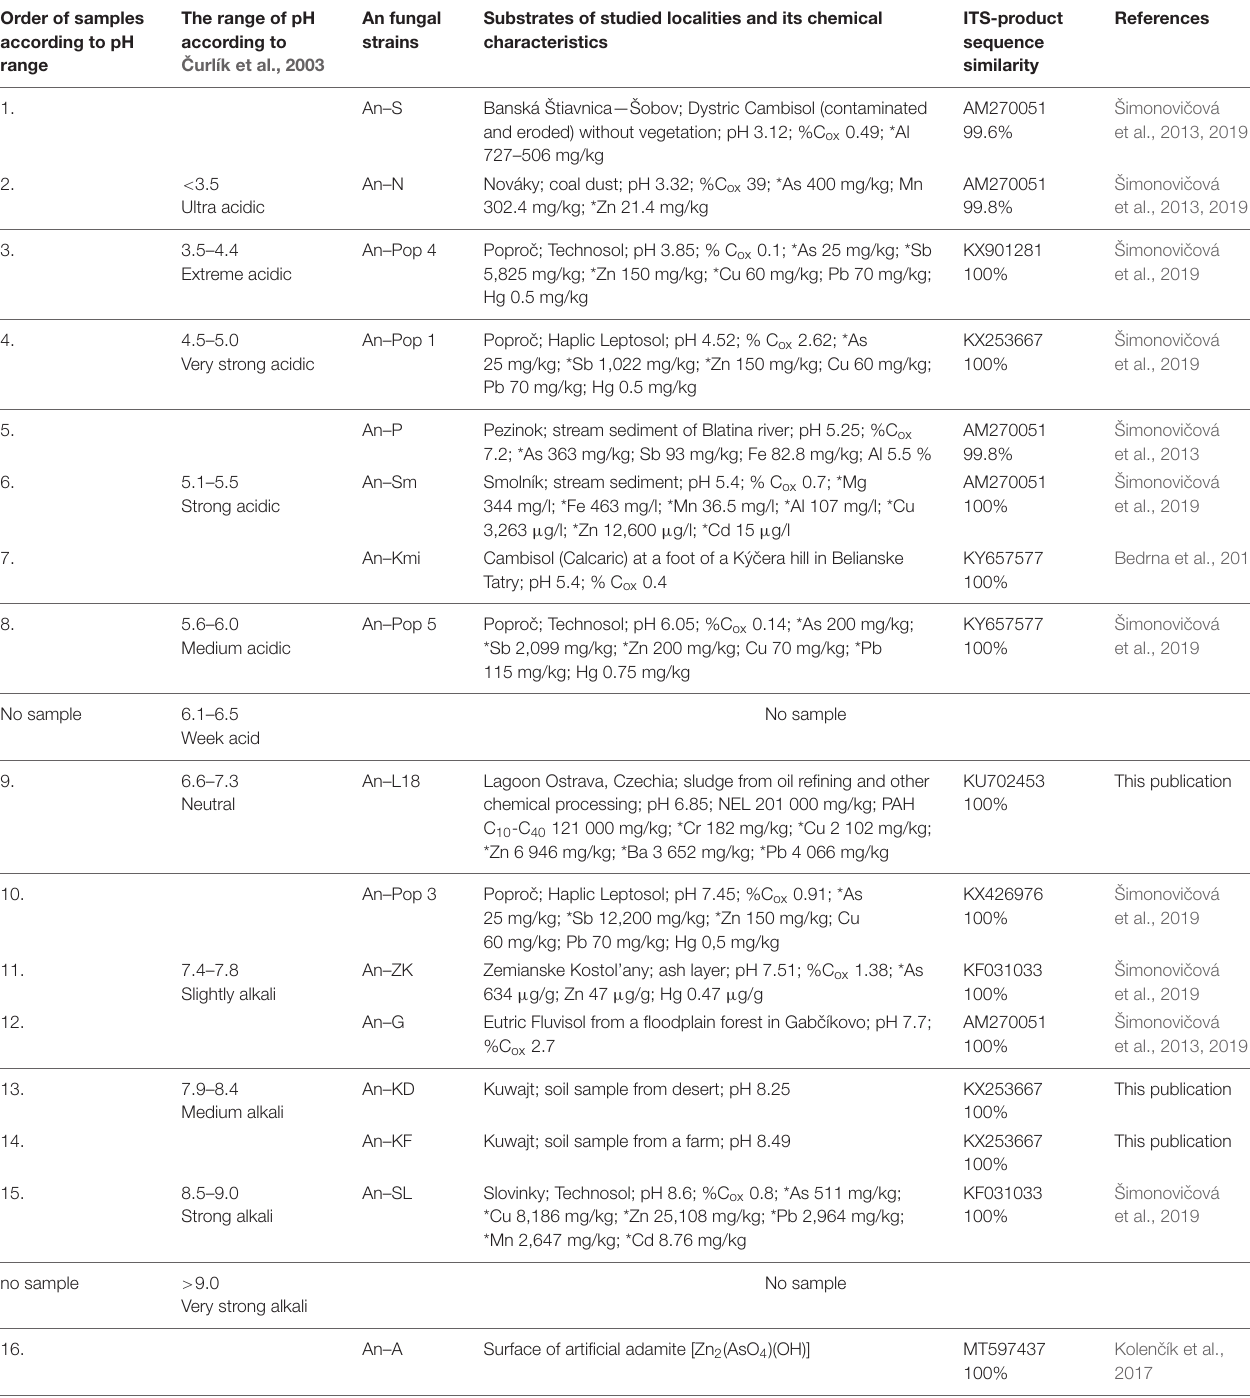
TABLE 1 | Aspergillus niger environmental isolates obtained from different type of soils and solid sources and its chemical characteristics. Order of samples The range of pH according to pH according to ˇCurlík et al., range